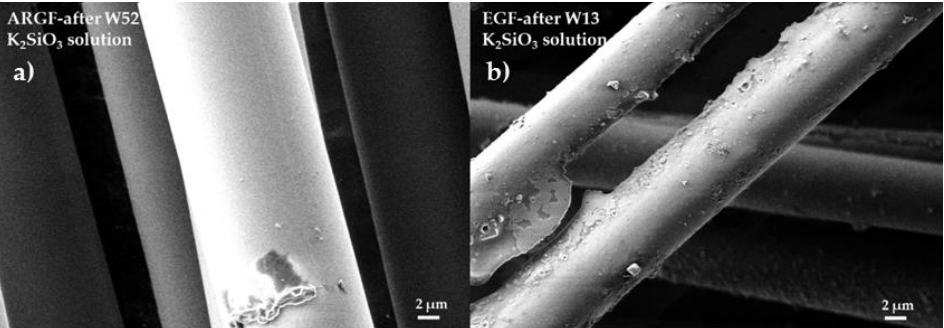
Figure 5. Surfaces of glass fibers treated with the K 2 SiO 3 solution: ( a ) ARGF after W52 and ( b ) EGF after W13.